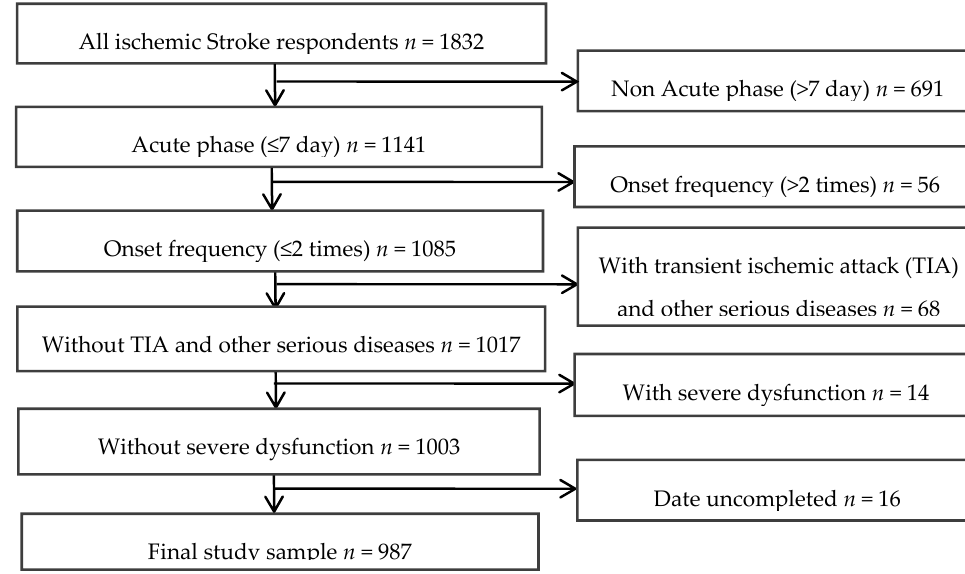
Figure 1. Flow chart in the selection of study patients.